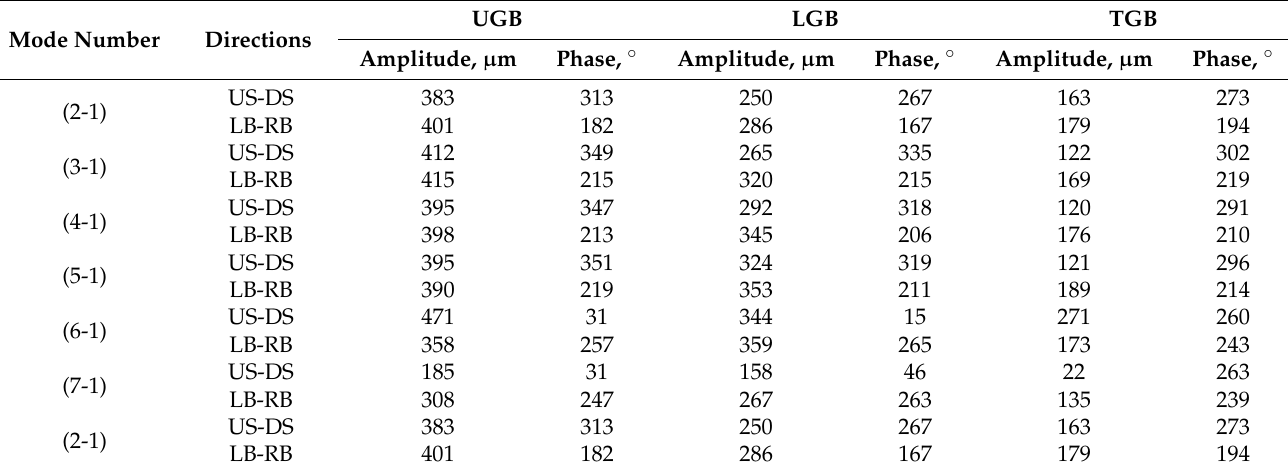
Table 2. Vector increments of the 1st harmonic on different operating modes.